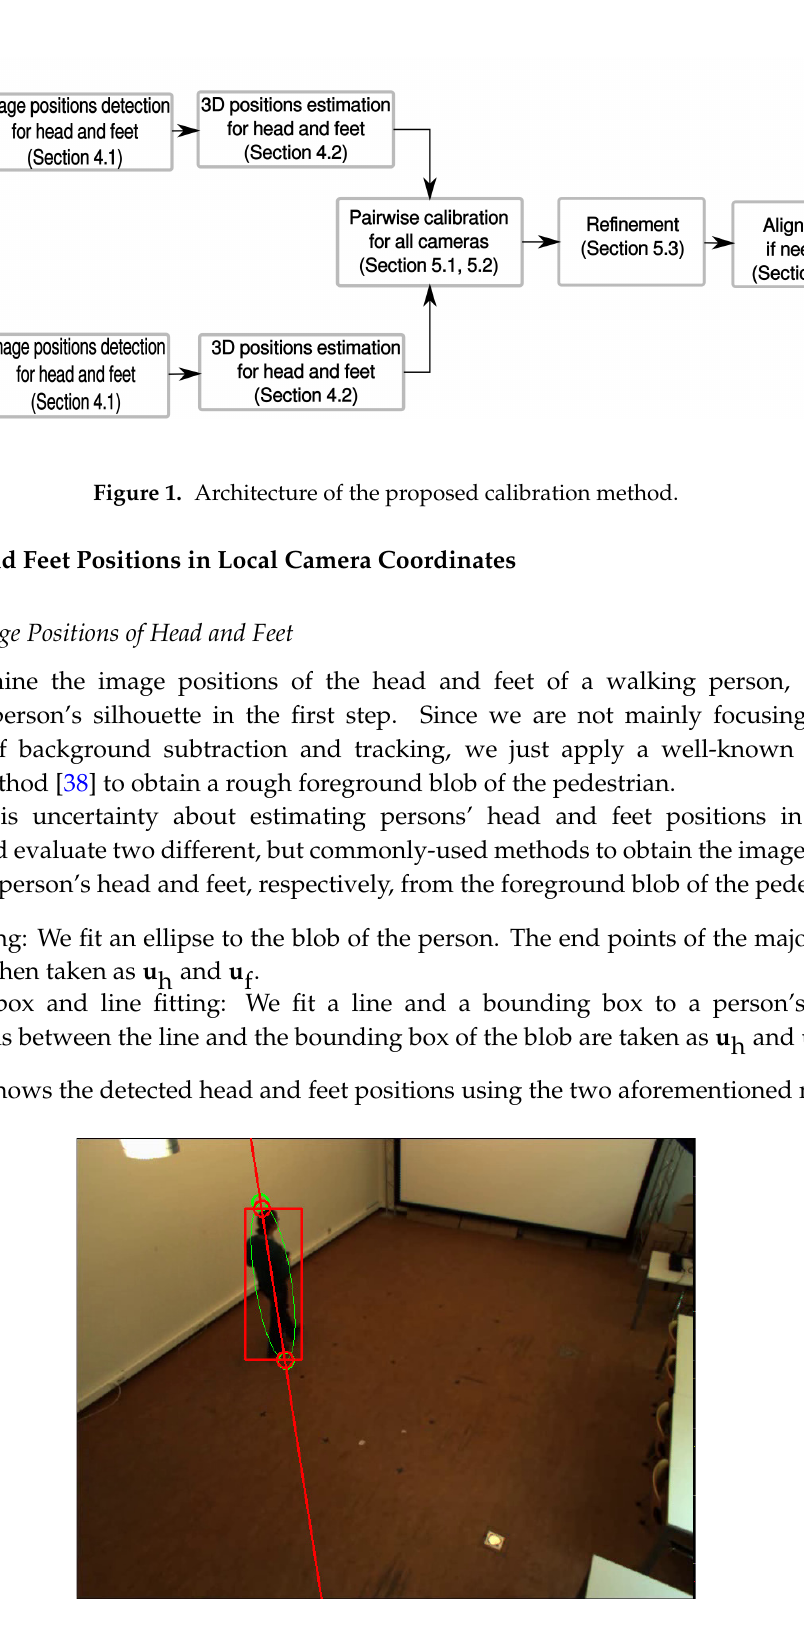
Figure 2. Head and feet detection in an image. Two green circles represent detected positions using ellipse fitting. Two red circles represent detected positions using bounding box fitting and line